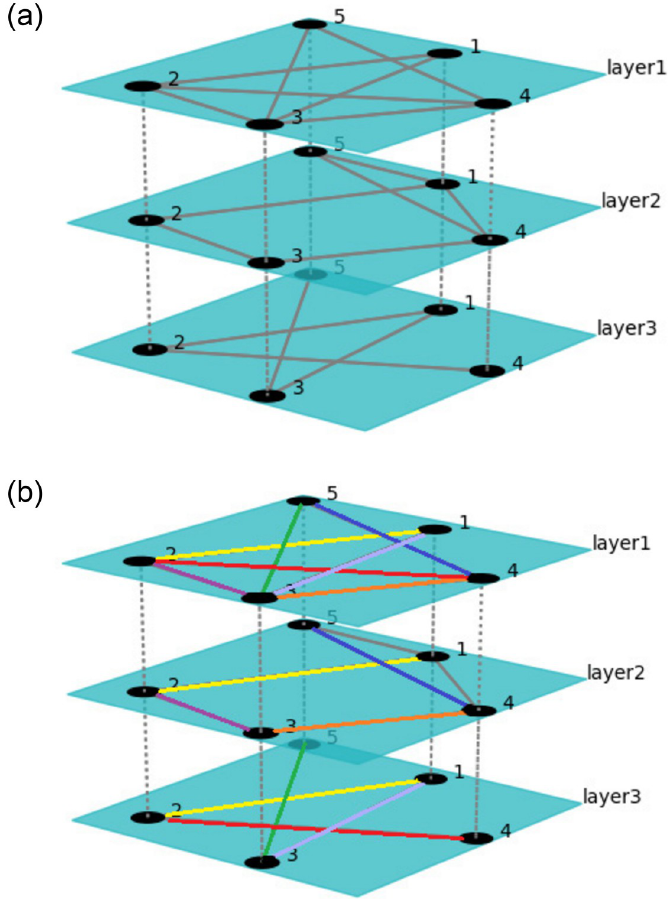
Fig 1. Schematic diagram of multiplex network structure with overlapping links at different layers. Fig 1(a) is a schematic diagram of a simple three-layer network, and the overlapping edges present in each network layer are marked in the same color in Fig